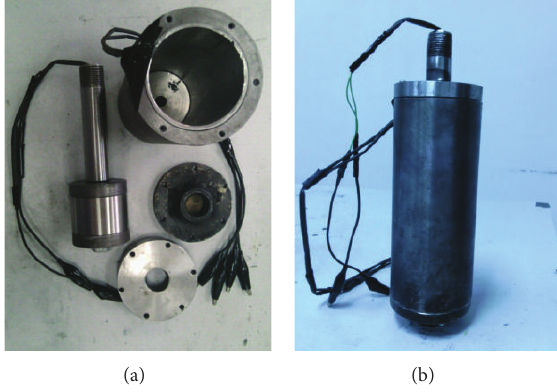
Figure 2: Prototyping of the proposed DDSMRD.